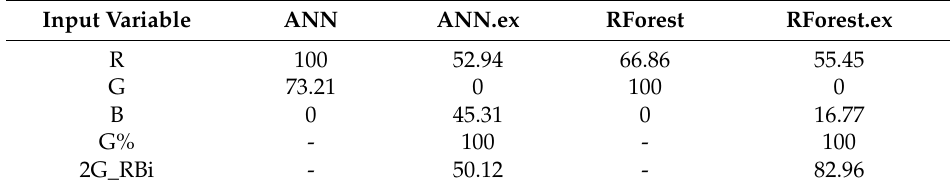
Table 4. Relative contribution to the overall accuracy of each input variable for the machine learning methods